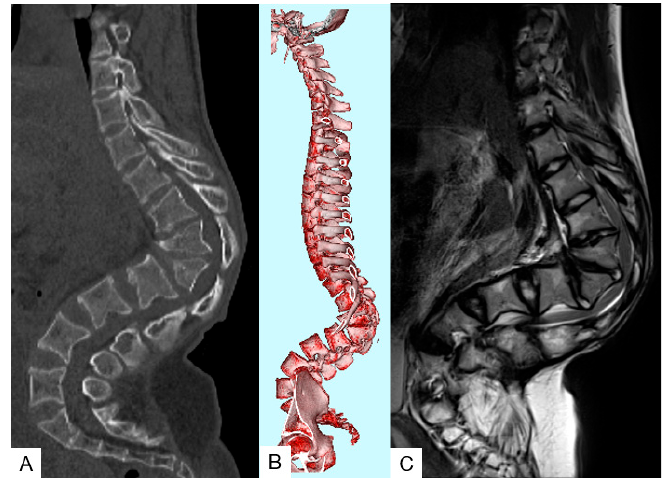
Figure 2. A 16-year-old girl with achondroplasia in preoperative state; preoperative CT and MRI. ( A ) Sagittal reconstruction CT image; ( B ) 3-D CT; ( C ) thoracolumbar sagittal T2-weighted MR imaging shows severe kyphosis and stenosis.